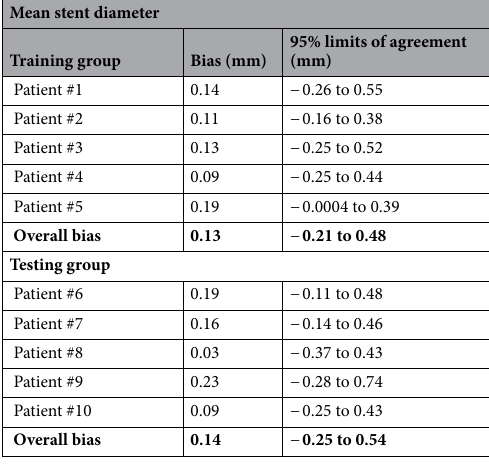
Table 6. Comparison of mean stent diameter between computational stenting versus optical coherence tomography in clinical cases by Bland–Altman